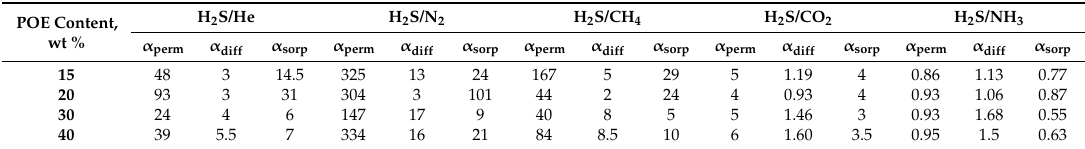
Table 6. Ideal selectivity for H 2 S/gas systems for polymer membranes obtained at different POE block